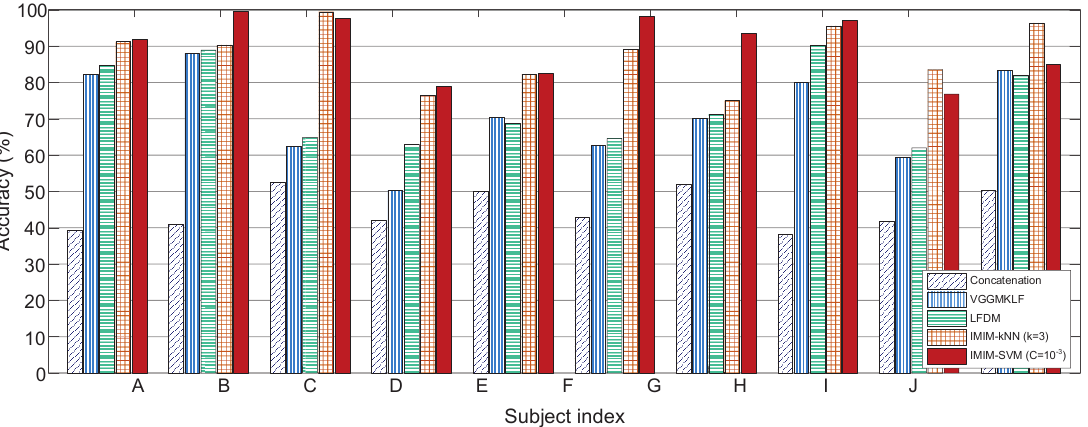
Figure 9. Comparison of feature level fusion methods according to ten subjects involved in this experiment. The subjects are numbered from A to J